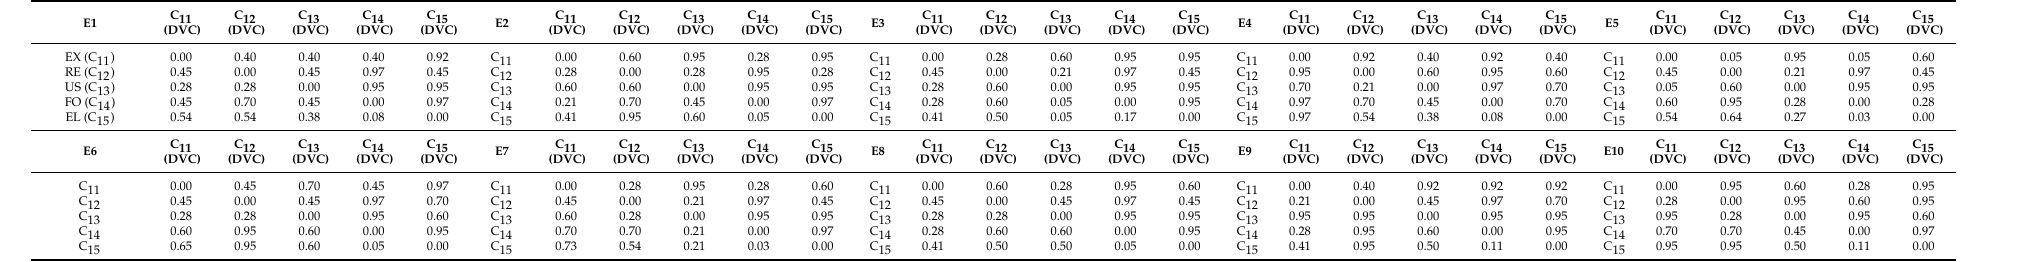
Table A12. The de-fuzzy crisp values for Triangle Fuzzy Numbers in Table